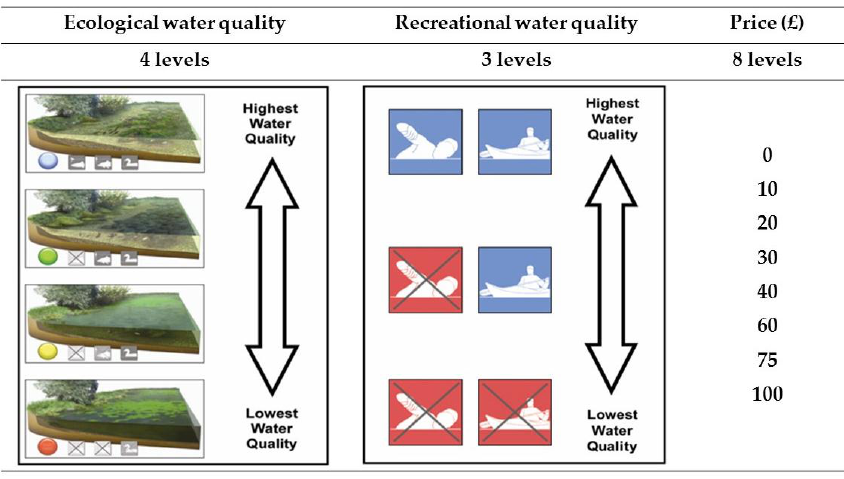
Figure 2. Choice experiment attributes and levels.